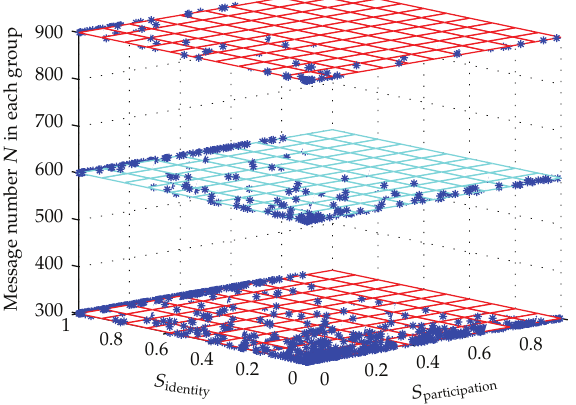
Figure 7: Intuitive relation between S identity , S participation , and N in each